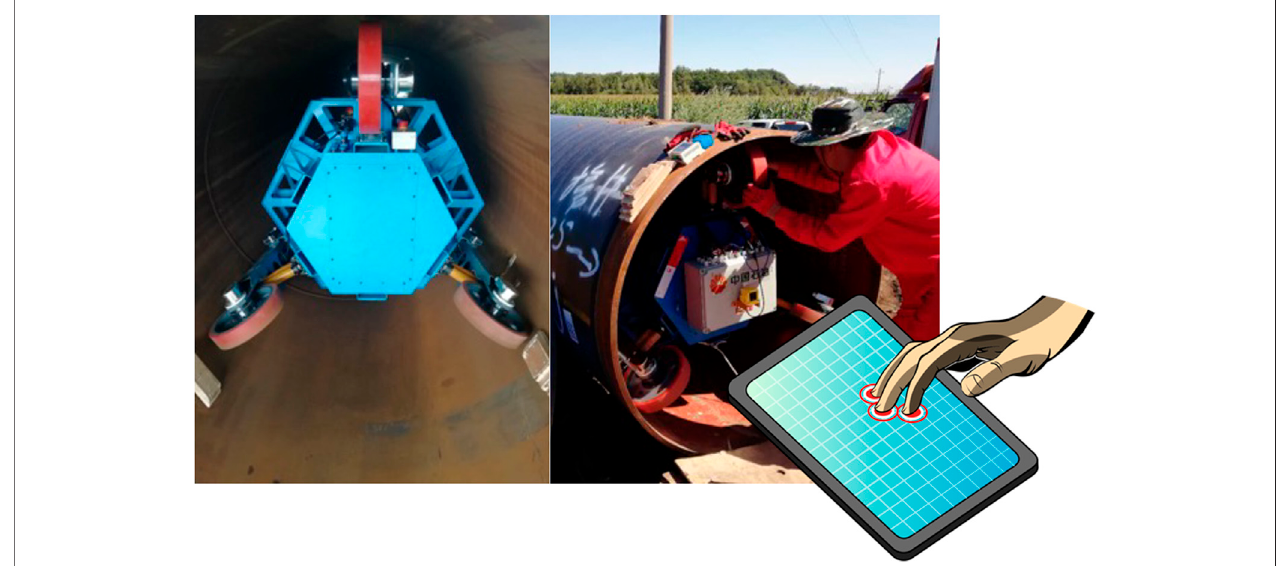
FIGURE 1 | Example of a robot used for petroleum pipelines inspection (modi fi ed from Li et al., 2020).